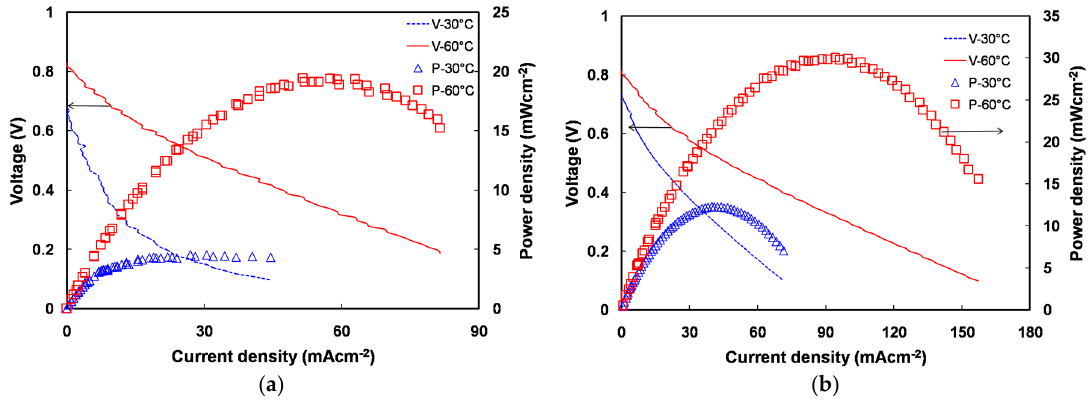
Figure 4. Direct methanol alkaline fuel cell (DMAFC) voltage (left axis) and power density (right axis) as a function of the current density at 30 °C and 60 °C using ( a ) CL-QPVA membrane and ( b